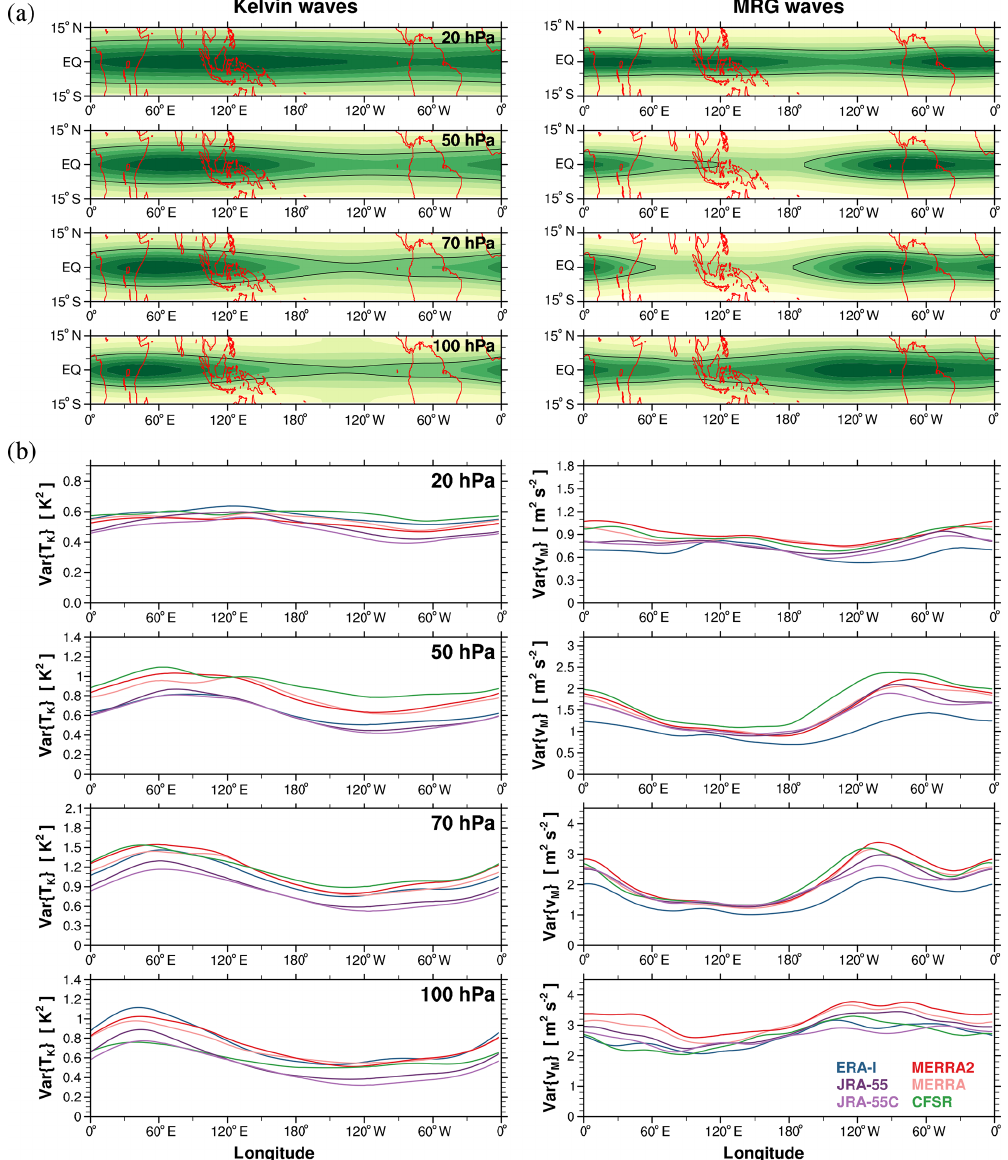
Figure 3. Horizontal distributions of variances of (left) temperature for the Kelvin waves ( T Kelvin ) and (right) meridional wind for the MRG waves ( v MRG ) at 100, 70, 50, and 20hPa averaged for 1981–2010: (a) ensemble mean for ERA-I, MERRA-2, CFSR, and JRA-55, and (b) distributions at the Equator for each of the six reanalyses. In panel (a) , the mean variances are normalized by their maximum value on each horizontal plane. The shading interval is 0.1, with the black contour indicating 0.5. See the text in Sect. 3.1 for the definitions of T Kelvin and v MRG